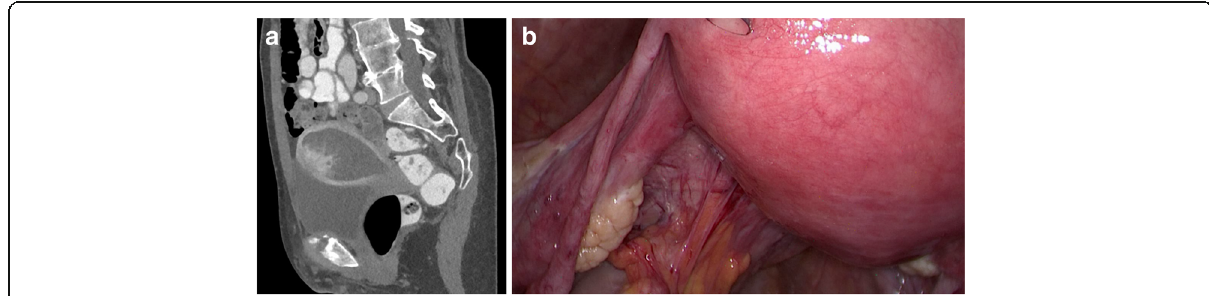
Fig. 1 Radiological and intra-operative findings: a CT radiography showed a serometra with a polypoid exophytic tumour mass with irregular borders with adjacent organs; b the situs during surgical laparoscopy with enlargement of the uterine fundus, inconspicuous serosal surface and